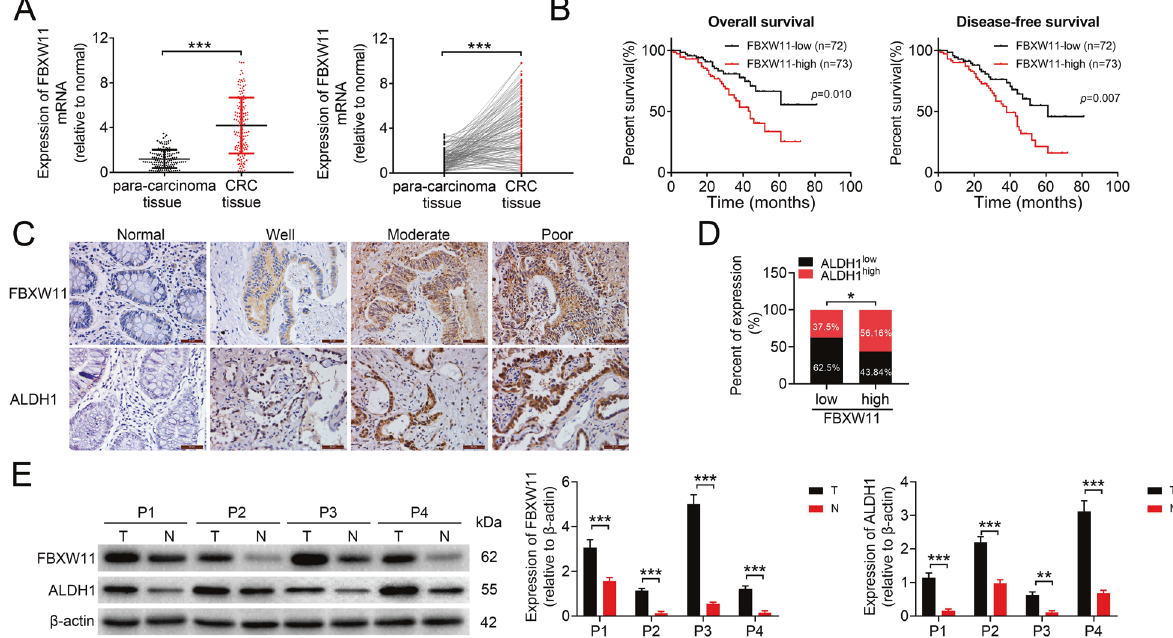
Fig. 1 Expression of FBXW11 in CRC tissue samples and its correlation with the prognosis of CRC patients. Colorectal tumor tissue and paired adjacent non-tumorous tissue samples were collected from 145 patients with CRC. A The mRNA level of FBXW11 in tissue specimens was measured by qRT-PCR. B The overall and disease-free survival of CRC patients with low or high FBXW11 expression was calculated using the Kaplan – Meier method. C The expressions of FBXW11 and ALDH1 in colorectal and adjacent non-tumorous tissue samples were detected by immunohistochemistry. Tissue samples with no staining (Normal, adjacent tissues), weak staining (Well), moderate staining (Moderate), and strong staining (Poor) were shown (×400 magni fi cation). D The SI of each section was calculated by multiplying the